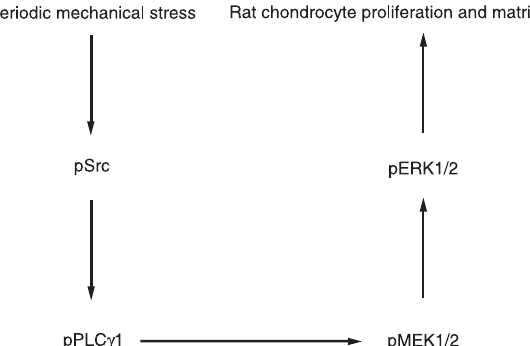
Figure 7. Schematic diagram of the signal transduction pathway of rat chondrocyte proliferation and matrix synthesis induced by periodic me- chanical